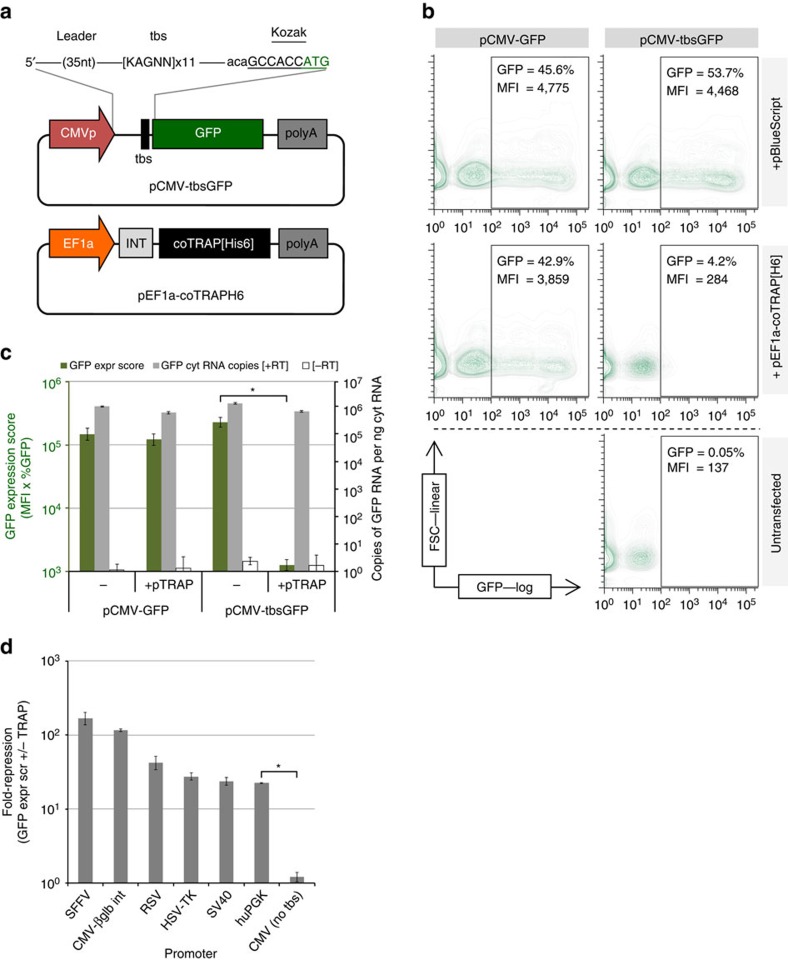
The TRAP-tbs configuration confers a translational block resulting in potent repression of GFP expression in HEK293T cells.(a) The GFP reporter plasmid containing the tbs within the 5′UTR of the transcription unit and the TRAP-expression plasmid used throughout the study. B. subtilis TRAP was codon-optimised for human cell expression and C-terminally Hisx6 tagged. (b) 2-D plots (FSC v FL1/GFP) of HEK293T cells co-transfected with GFP reporter plasmids and TRAP or control plasmids, analysed by flow cytometry (MFI, median fluoresence intensity [arbitrary units]). (c) GFP Expression scores for the co-transfections were generated (percent GFP × MFI; plotted on left y-axis) and qRT-PCR data of cytoplasmic GFP RNA copies detected plotted on the right y-axis; grey bars—RT-positive, white bars—no RT (residual pDNA control). All data are mean average values±s.d. [log10-transformed data] (n=8); *P<1.7 × 10−17 [Welch's t-test]. (d) Fold repression of GFP Expression Scores (difference in ±TRAP) of other promoters tested in the ‘promoter-tbs-GFP' configuration in co-transfected HEK293T cells±pEF1a-coTRAP[H6] (note that total fold repression is related to promoter strength due to a greater differential between ‘on' levels compared to untransfected cells). Data are mean average values±s.d. [log10-transformed data] (n=3); *P<0.001 [Welch's t-test]. (CMVp, cytomegalovirus promoter; EF1a, Elongation factor 1 alpha promoter; INT, synthetic intron; tbs, TRAP-binding sequence; coTRAP[Hisx6], codon-optimized tryptophan RNA-binding attenuation protein with C-terminal Histine tag; polyA, polyadenylation signal; SFFV, spleen focus-forming virus promoter; CMV+betaglb intron; CMV promoter with human beta globin intron; RSV, Rous Sarcoma Virus promoter; HSV-TK, Herpes simplex virus thymidine kinase promoter; SV40, Simian virus 40 promoter; huPGK, human phosphoglycerate kinase 1 promoter). are representative of two independent experiments.